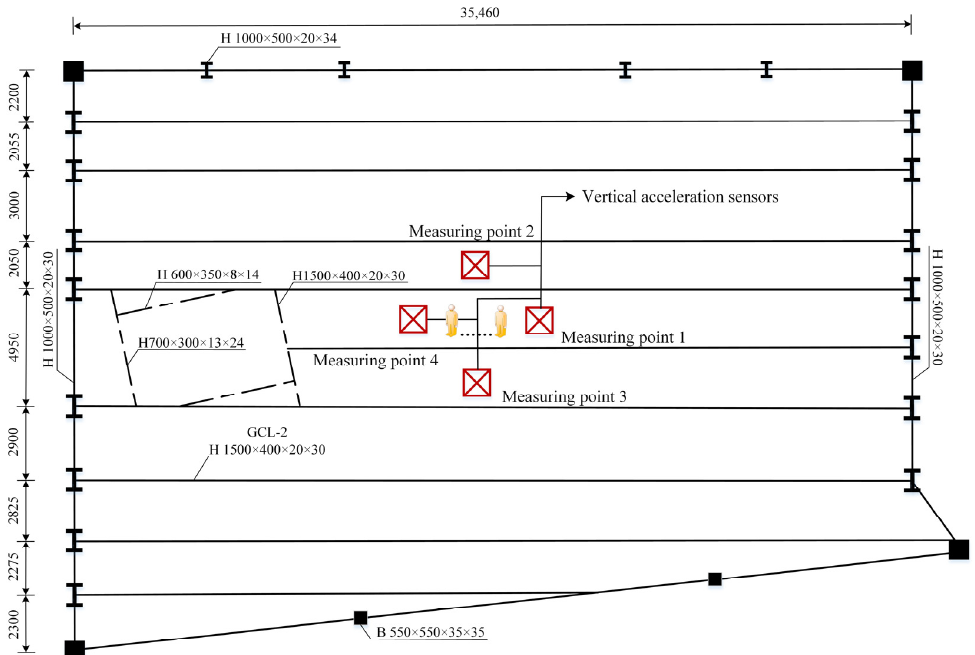
Figure 2. The schematic diagram of the test setup for the dynamic characteristic test.